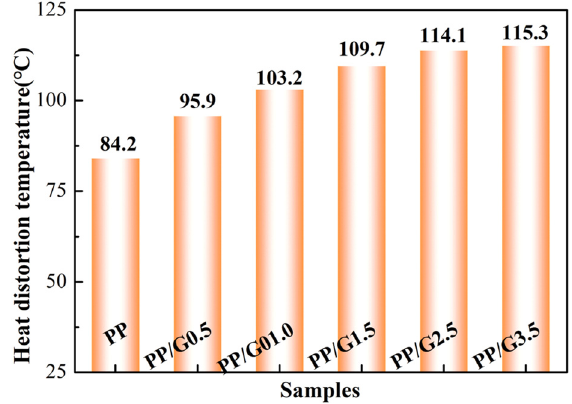
Figure 6: Heat distortion temperature of neat PP and PP/GNP